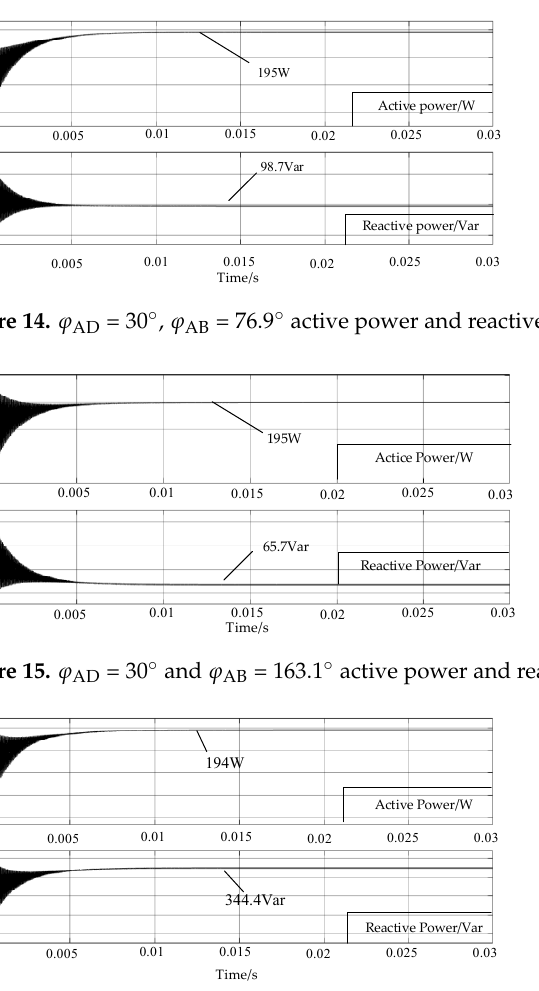
Figure 16. φ AD = 90° and φ AB = 103° active power and reactive power waveforms.